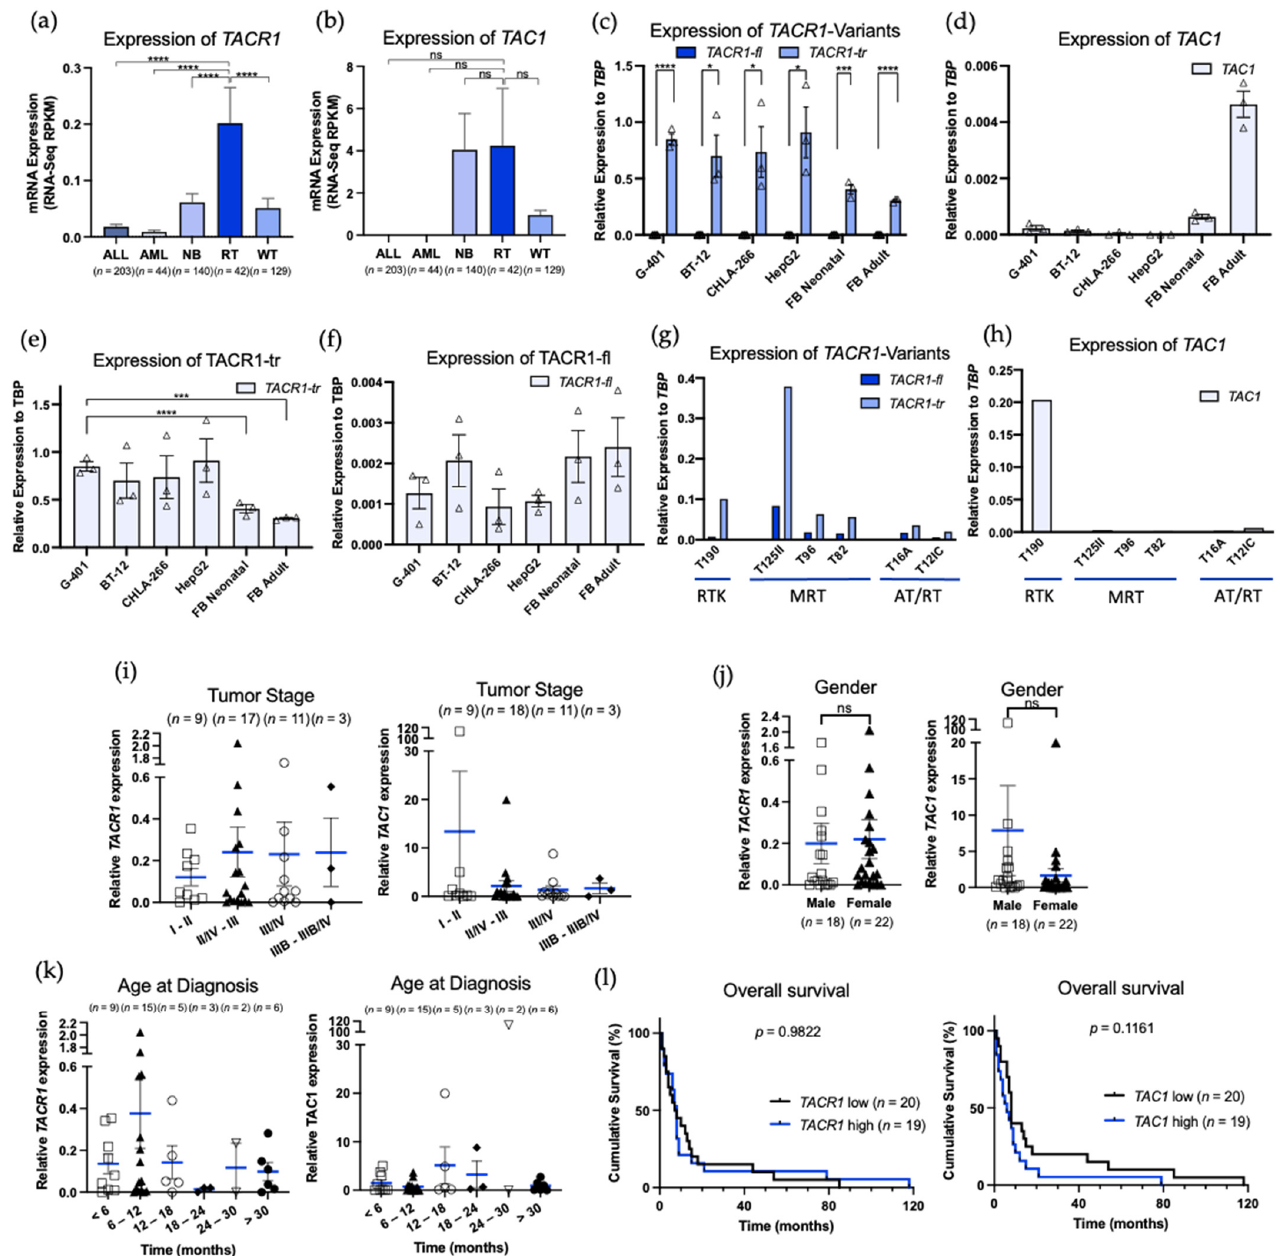
Figure 1. Expression of TACR1 and TAC1 and biological and clinical parameters of rhabdoid tumors. ( a , b ) mRNA expression of TACR1 and TAC1 in ALL ( n = 203), AML ( n = 44), NB ( n = 140), RT ( n = 42), and WT ( n = 129). Relative expression was correlated to the ( i ) tumor stage by the Neoplasm American Joint Committee on Cancer (I-II n = 9; II/IV-III n = 17 for TACR1, n = 18 for TAC1; III/IV n = 11; IIIB-IIIB/IV n = 3), ( j ) gender (Male n = 18; Female n = 22), ( k ) age at diagnosis (months) (< 6 months n = 9; 6–12 months n = 15; 12–18 months n = 5; 18–24 months n = 3; 24–40 months n = 2; > 30 months n = 6), ( l ) overall survival (months) (TACR1 low n = 20; TACR1 high n = 19; TAC1 low ( n = 20), TAC1 high n = 19), and ( c – f ) mRNA expression of TACR1-fl , TACR1-tr, and TAC1 in G-401, BT- 12, CHLA-266, HepG2, and in FB Neonatal (=fibroblasts neonatal, PCS-201-120) and in FB Adult (=fibroblasts adult, PCS-201-012) normalized to the housekeeping gene TBP . ( g , h ) mRNA expression of TACR1-fl , TACR1-tr and TAC1 in tumor samples normalized to TBP . Results are expressed as the mean ± standard error of the mean (SEM). All statistical comparisons were made with an unpaired parametric t-test comparing two groups, an ordinary one-way ANOVA or a Tukey´s multiple com- parison test, with a single pooled variance. ns = not significant. p < 0.05 (*), p < 0.001 (***) and p < 0.0001 (****) for all comparisons.